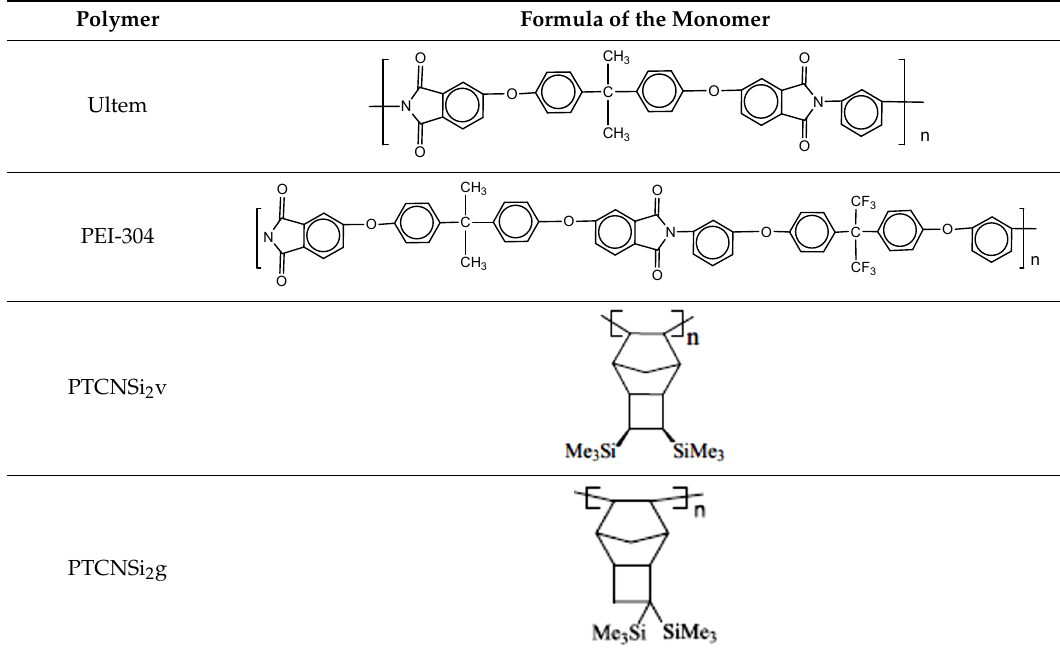
Table 1. Structure of the polymers studied.